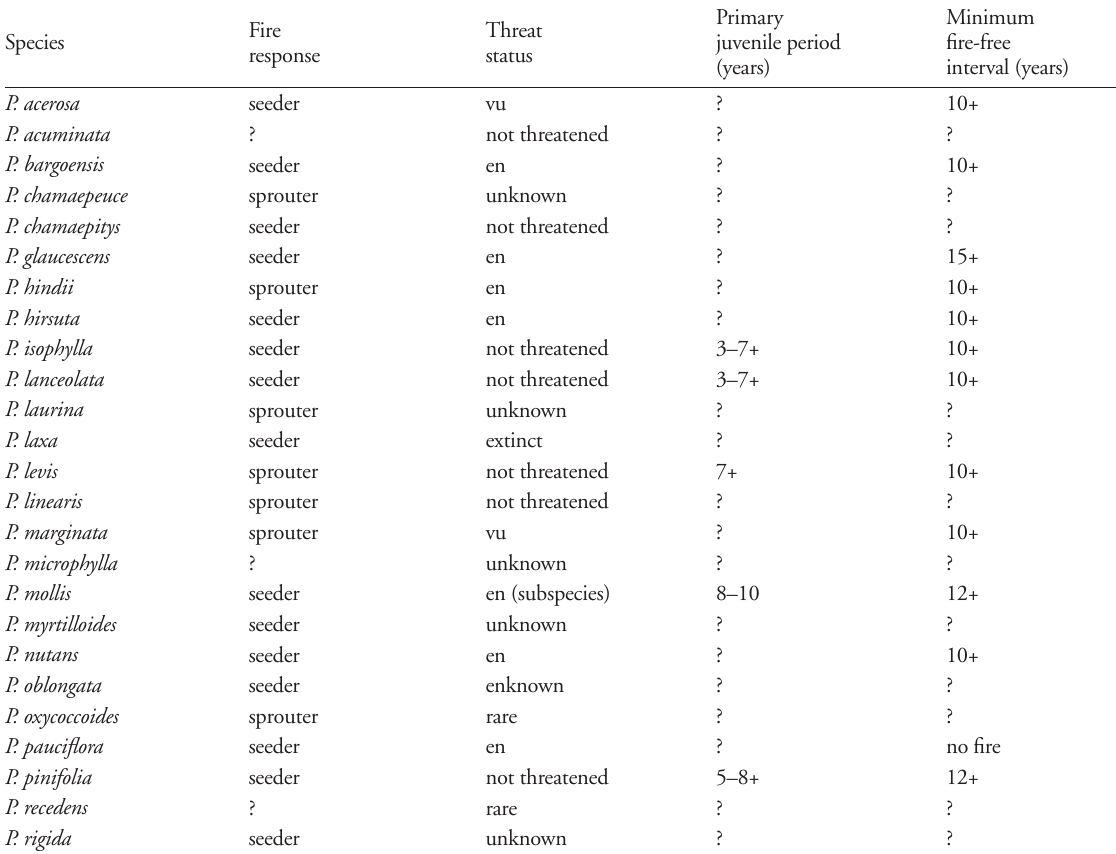
Table 1. Fire response and time to maturity in Persoonia species from the Sydney basin (data compiled from Benson and McDougall 2000, NSW National Parks and Wildlife Service fire response register 2002, T. D. Auld unpubl.). Threat status: en – endangered, vu – vulnerable. The minimum fire-free interval is the recommended interval between fires that must be allowed for species persistence (from NSW Rural Fire Service 2006, T. D. Auld